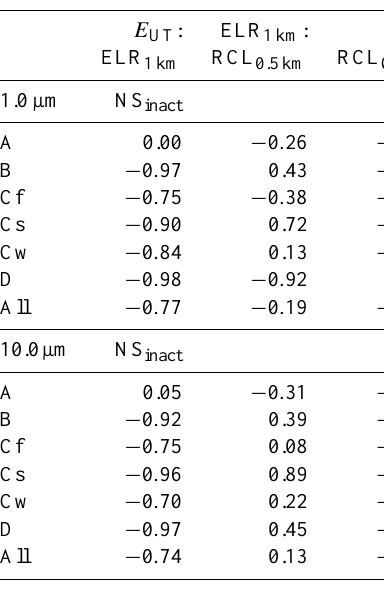
Table 4. Pearson correlation coefficients for correlations between E UT , ELR 1km , and RCL 0.5km , climate class resolved and for all MPCs (row All) for small (1.0µm) and large (10.0µm) aerosol